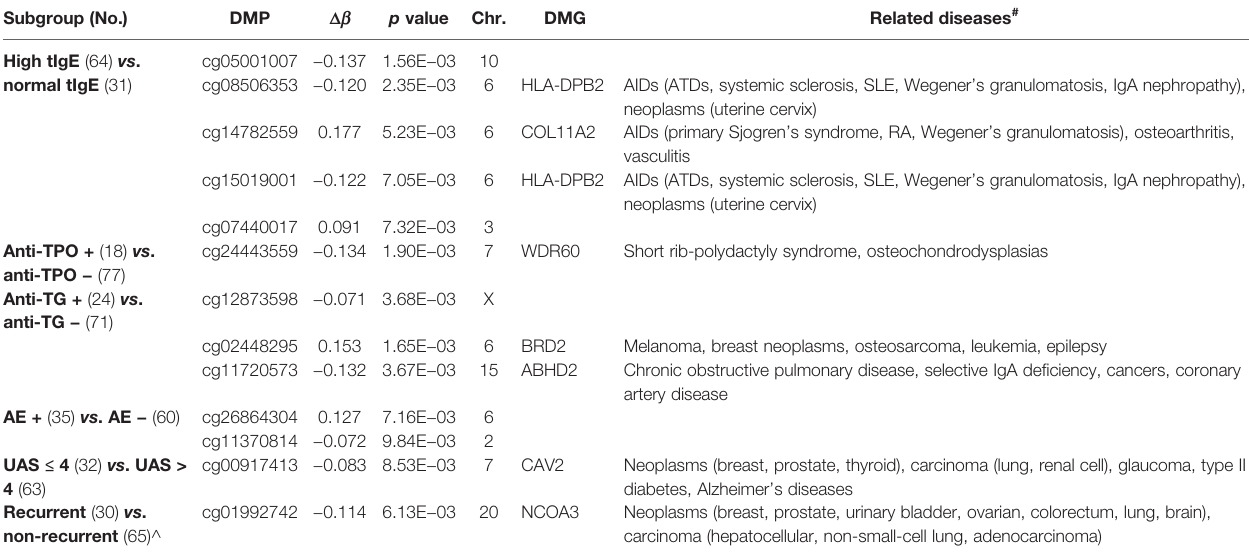
TABLE 4 | Number of differentially methylated positions (DMPs) ( p < 0.01 and | D b | ≥ 0.06) in the six pairs of subgroups of CSU patients. Subgroup (No.) D b p value